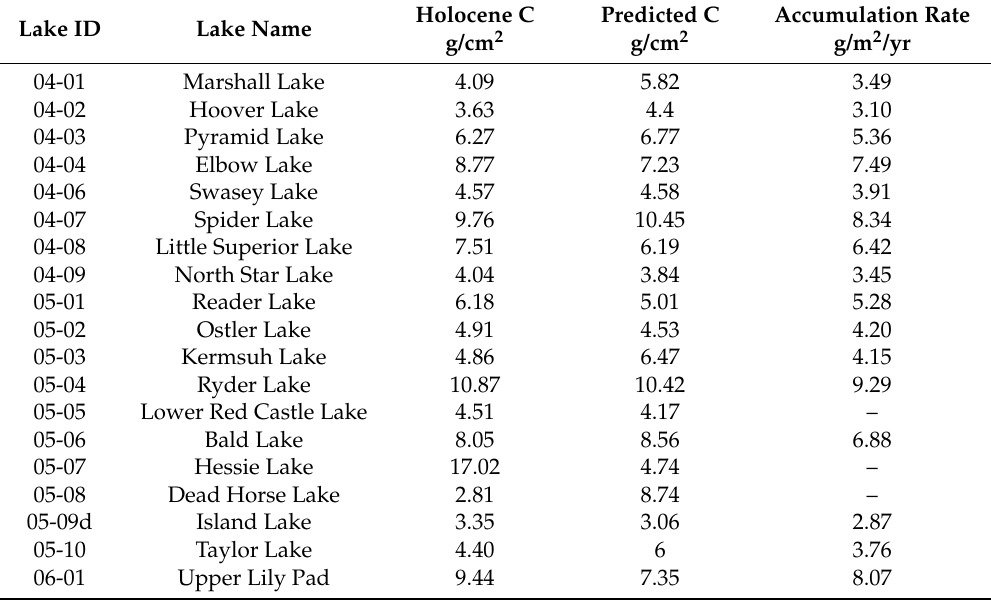
Table 2. Calculated and Predicted Holocene C.